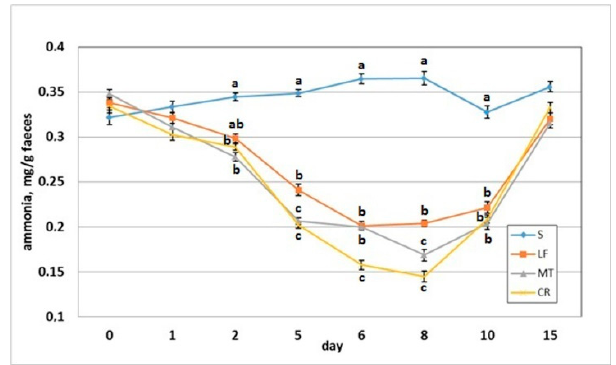
Figure 7. Faecal ammonia concentration of rats fed diets supplemented with lactoferrin, melittin or cecropin A. Experimental factor in particular groups: S—control standard diet (0–15 days); LF— standard diet with lactoferrin addition 100 mg/kg (0–5 days diet LF and 6–15 days diet S); MT— standard diet with melittin addition 100 mg/kg (0–5 days diet MT and 6–15 days diet S); CR—standard diet with cecropin A addition 100 mg/kg (0–5 days diet CR and 6–15 days diet S). a,b,c Mean values on the day with no common superscript are different at p ≤ 0.05. Data are presented as the mean with SEM; SEM—SD for all rats divided by the square root of rat number in one group ( n =